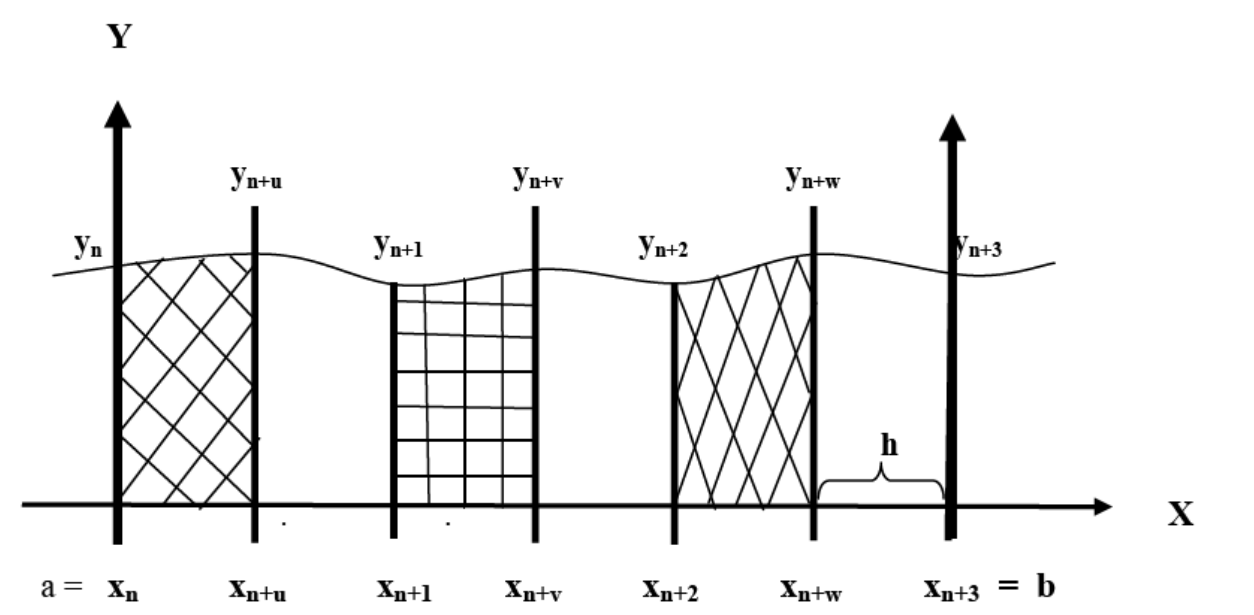
Figure 1. Schematic representation of the block hybrid methods for stiff system of initial value problems.